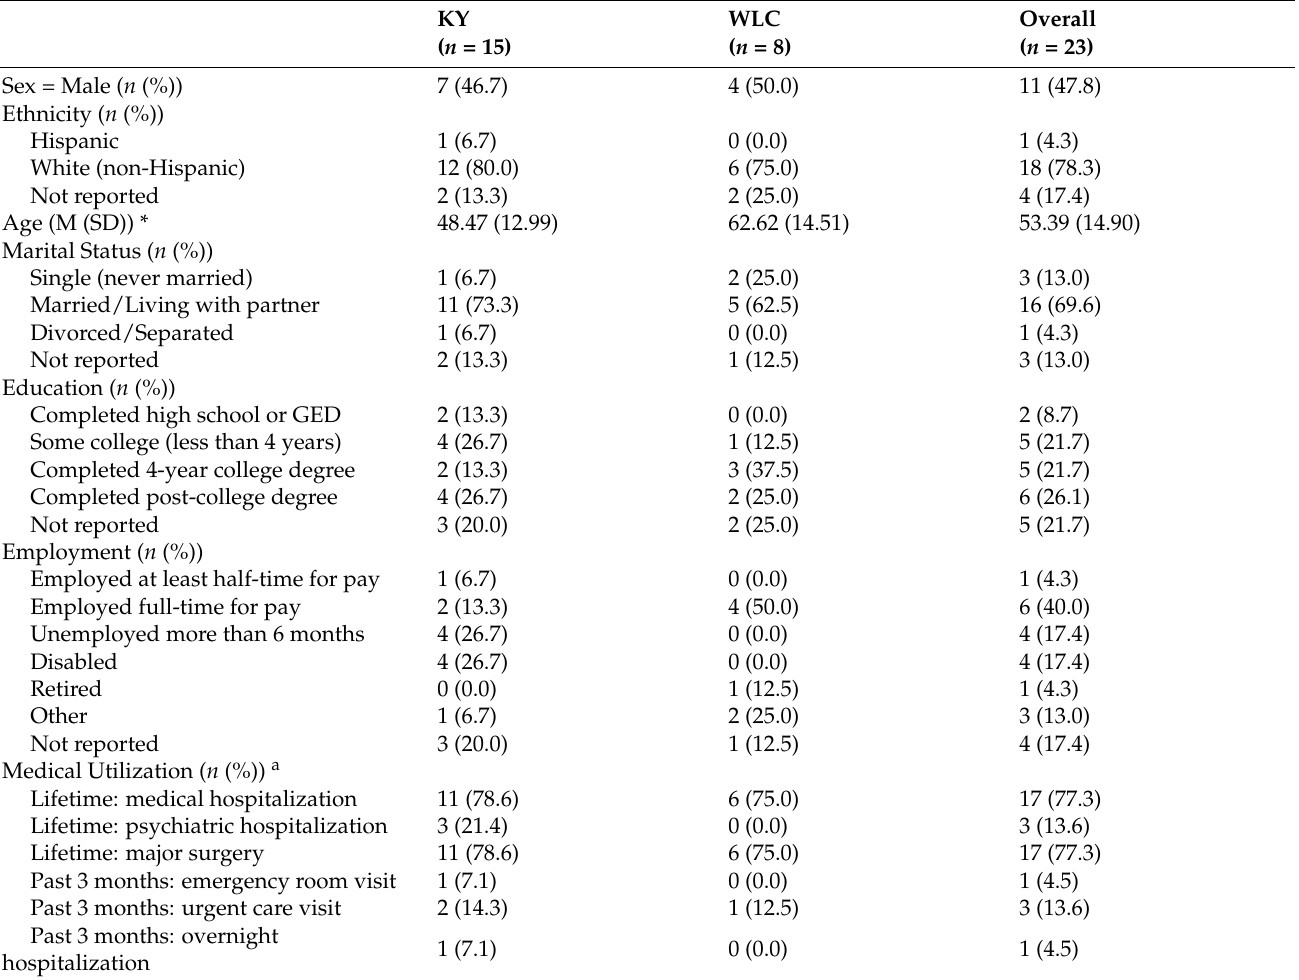
Table 1. Demographics and clinical characteristics of participants who received allocated